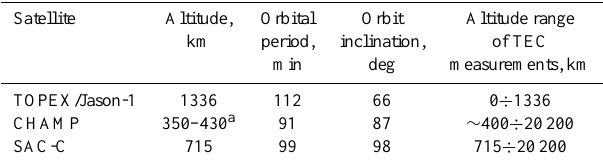
Table 1. TOPEX/Jason-1, CHAMP and SAC-C satellite orbital pa-